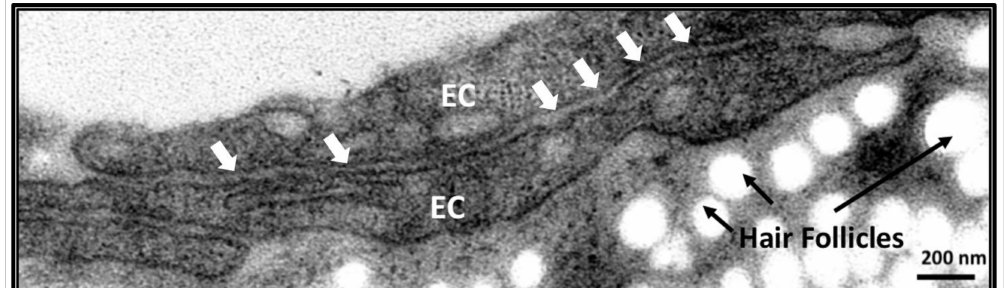
Figure 1. High-resolution transmission electron micrograph showing an endothelial adherens junc- tion in adult mouse skin. EC stands for endothelial cell. The white arrows indicate the adherens junction between two overlapping ECs. The white spots are the hair follicles in the mouse skin. Scale bar is 200